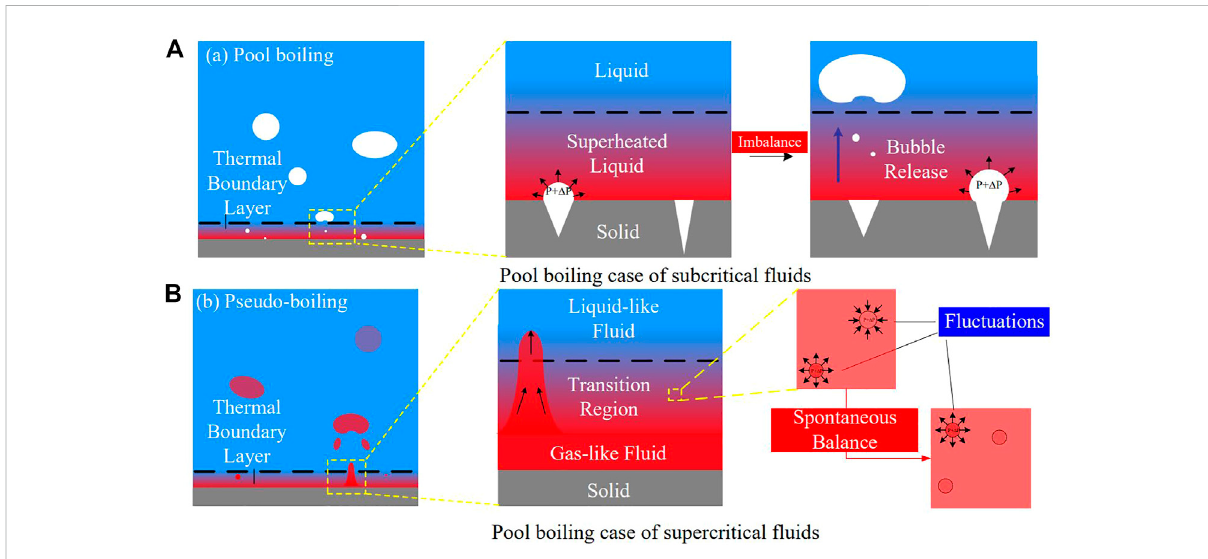
FIGURE 3 Different heat transfer mechanisms of the (A) subcritical gas-liquid transition and (B) pseudo-critical